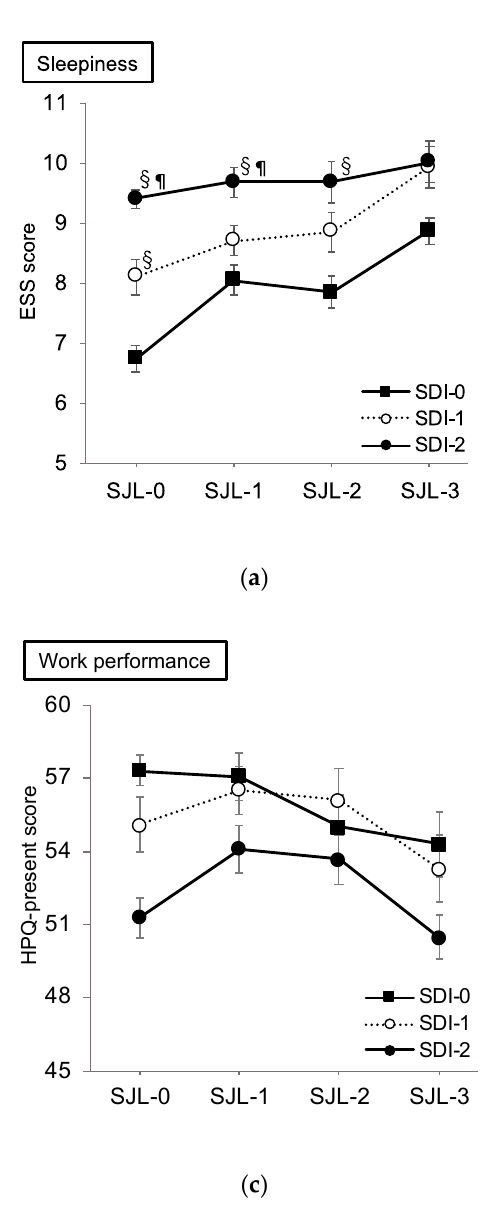
Figure 4. Effects of sleep debt index and social jetlag on sleepiness, depressive mood, and performance. ( a ) Effects of SDI and SJL on sleepiness; ( b ) effects of SDI and SJL on depression; ( c ) effects of SDI and SJL on work performance. CES-D, Center for Epidemiological Studies-Depression Scale; ESS, Epworth Sleepiness Scale; HPQ-presenteeism, WHO Health and Work Performance Questionnaire-presenteeism; SDI, sleep debt index; SJL, social jetlag. Error bars indicate standard errors. § In each SJL group, statistically significantly different from SDI-0 at p < 0.01. ¶ In each SJL group, statistically significantly different from SDI-1 at p < 0.01. Table 2. Mean and SD of the scales for daytime function measures in each category.